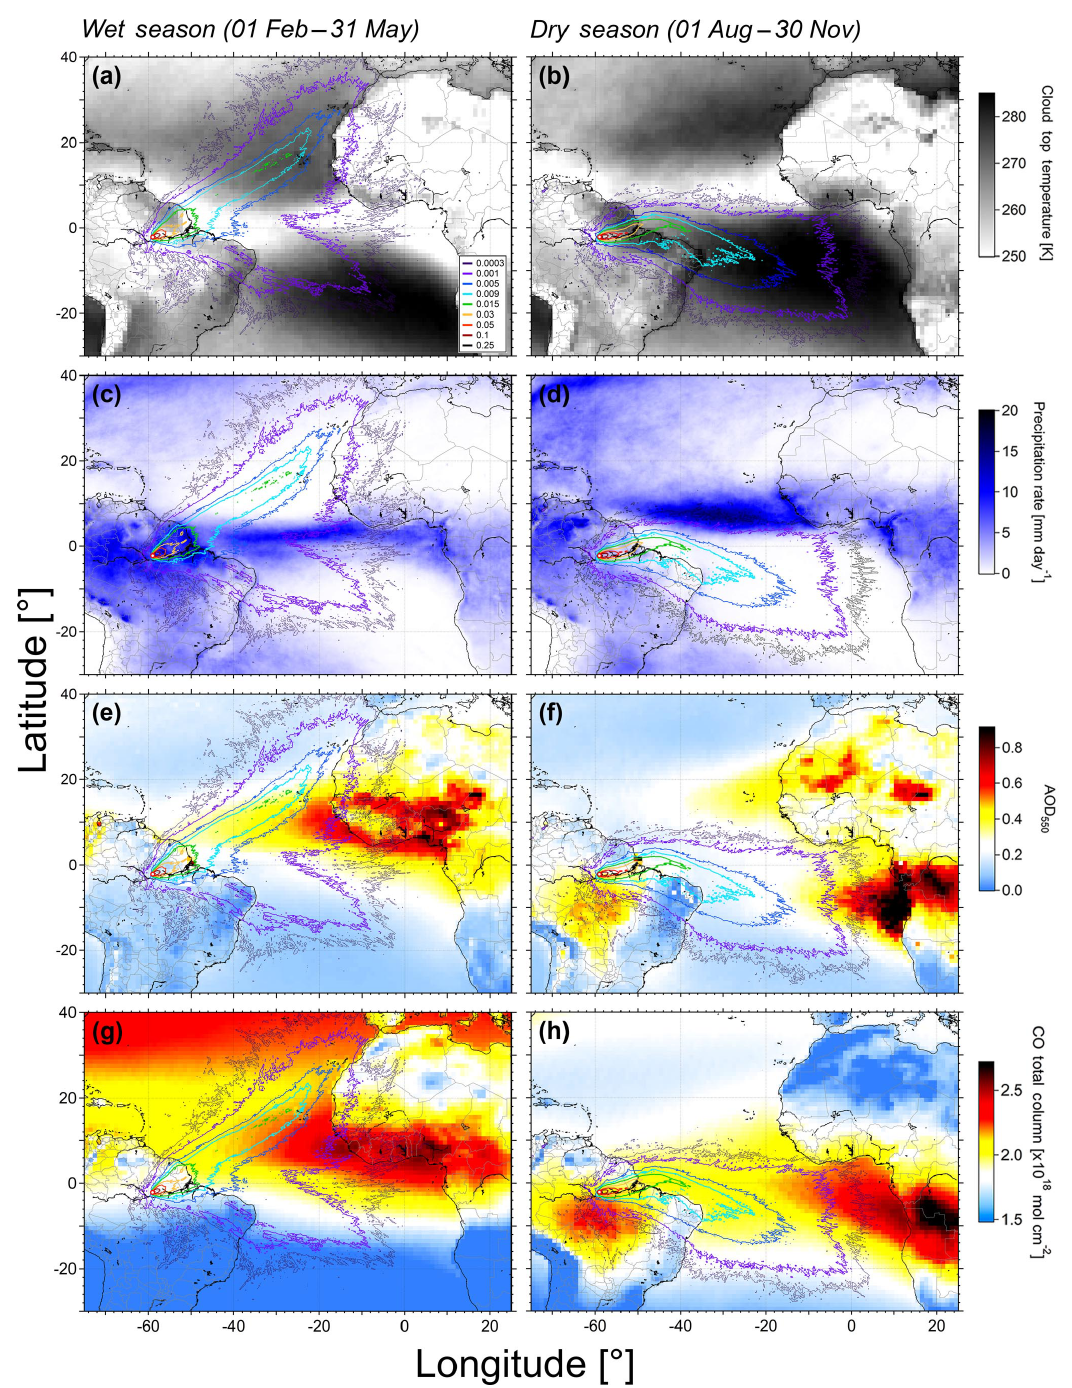
Figure 1. Composite maps combining backward trajectory ensembles with satellite data products contrasting wet and dry conditions in Amazonia. Multi-year time periods from 2008 to 2016 were averaged to retrieve representative results. All wet season data shown here represent averages of the months February–May and the dry season data represent averages of the months August–November. Backward trajectory ensembles are shown as contour plots with contour lines representing fraction of occurrence of overpassing trajectories in a certain region as described in Pöhlker et al. (2018) (see legend in a ). (a, b) MODIS-derived cloud top temperature data showing location of ITCZ belt with deep convective clouds and corresponding cold cloud tops. (c, d) TRMM-derived precipitation rate showing regions where strong rain-related aerosol scavenging is expected. The belt with strongest precipitation rates is collocated with the ITCZ. (e, f) MODIS-derived aerosol optical depth (AOD) illustrating the dominant aerosol sources in Africa and South America relevant for the ATTO site measurements. (g, h) AIRS-derived CO maps illustrating hot spots of biomass burning with strong CO